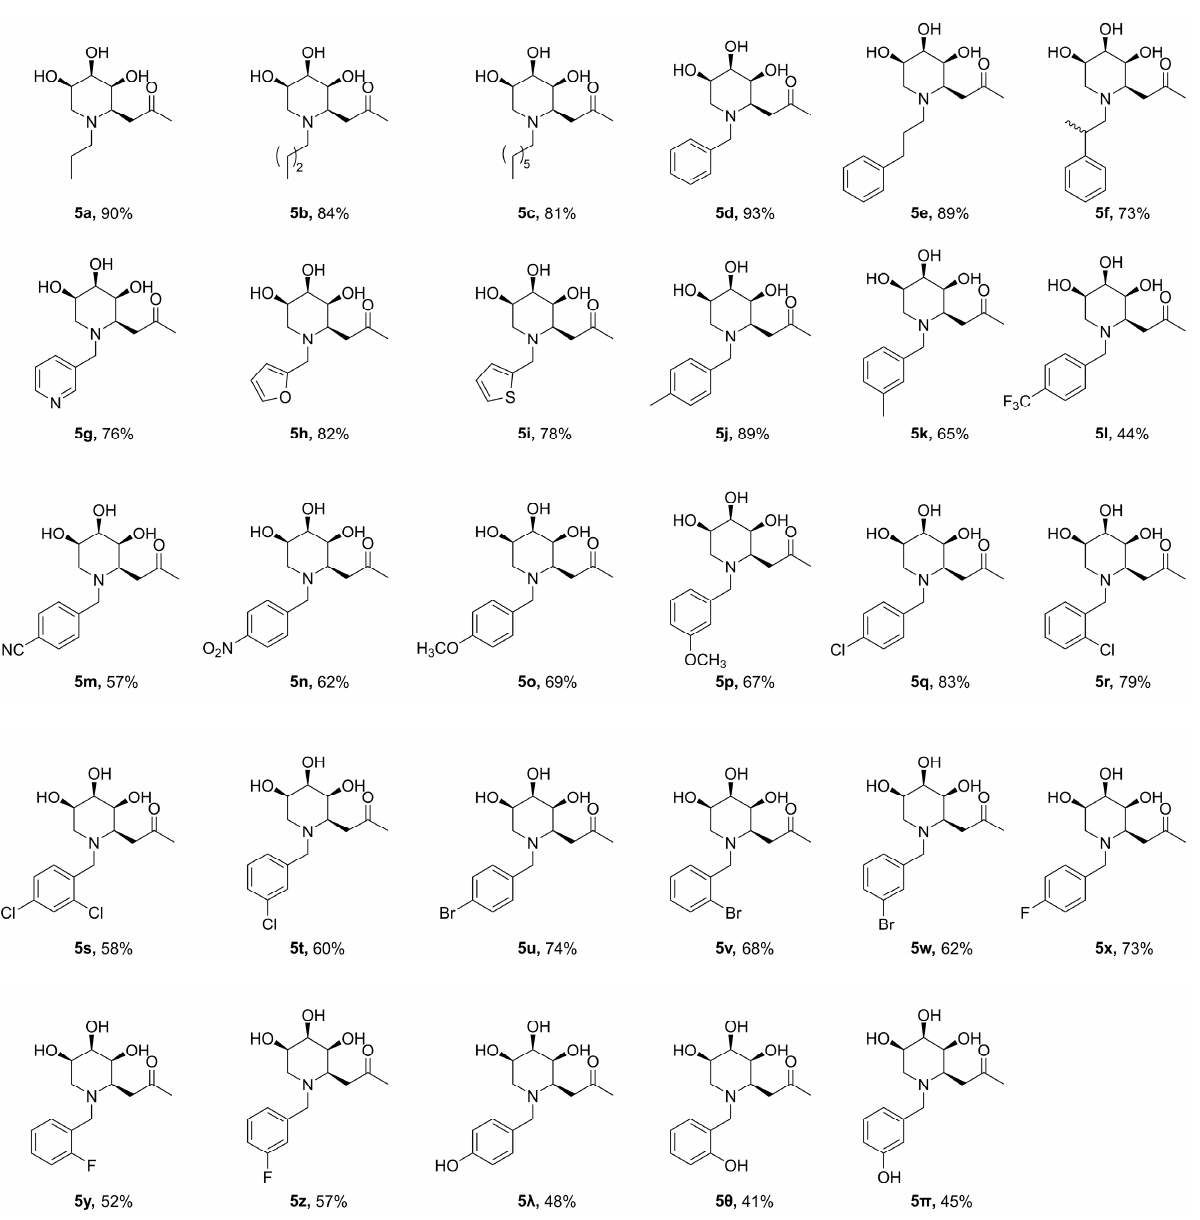
Figure 2. Synthesized N ‐ substituted iminosugar C ‐ glycosides ( 5a – 5 π ).